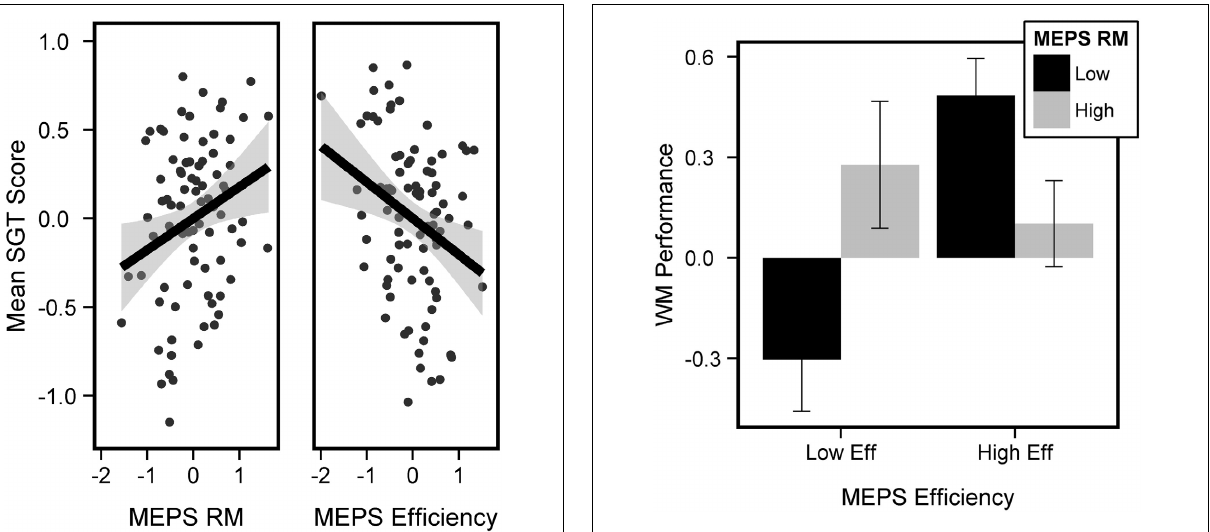
FIGURE 4 | Link between SGT and MEPS performance. Mean SGT was associated with higher number of RM (left panel) but lower efficiency (right panel). Mean SGT Score corresponds to the mean of [ST-FSO in CRT, ST-FSO in WM, ST-PO in CRT, and ST-PO in WM] computed for each subject. Black lines represent best-fitted linear regressions and gray areas represent 95% confidence intervals.